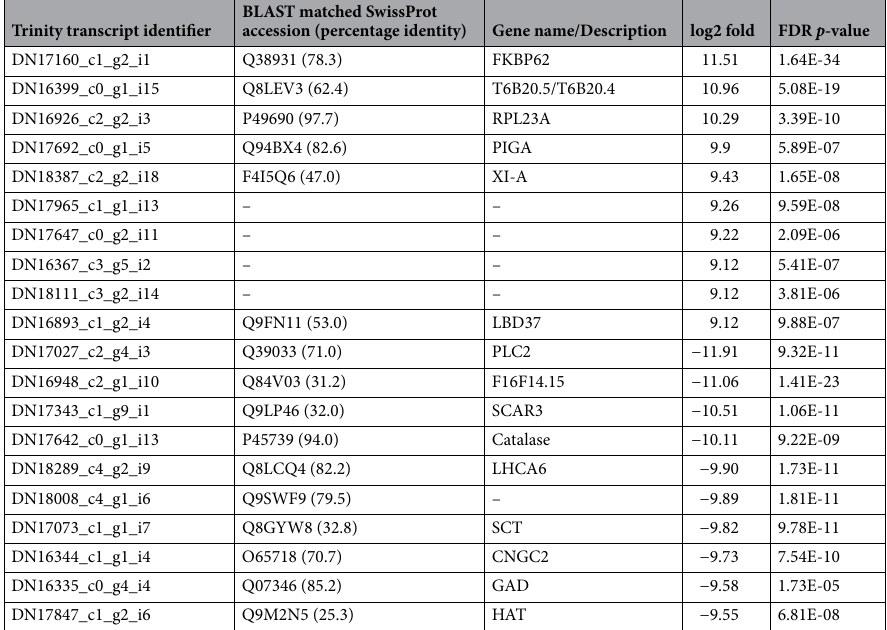
Table 6. Top 20 differentially expressed transcripts between red and white light treated samples. Positive and negative fold changes indicate up- and down-regulation, respectively, in red light compared to white light exposed samples